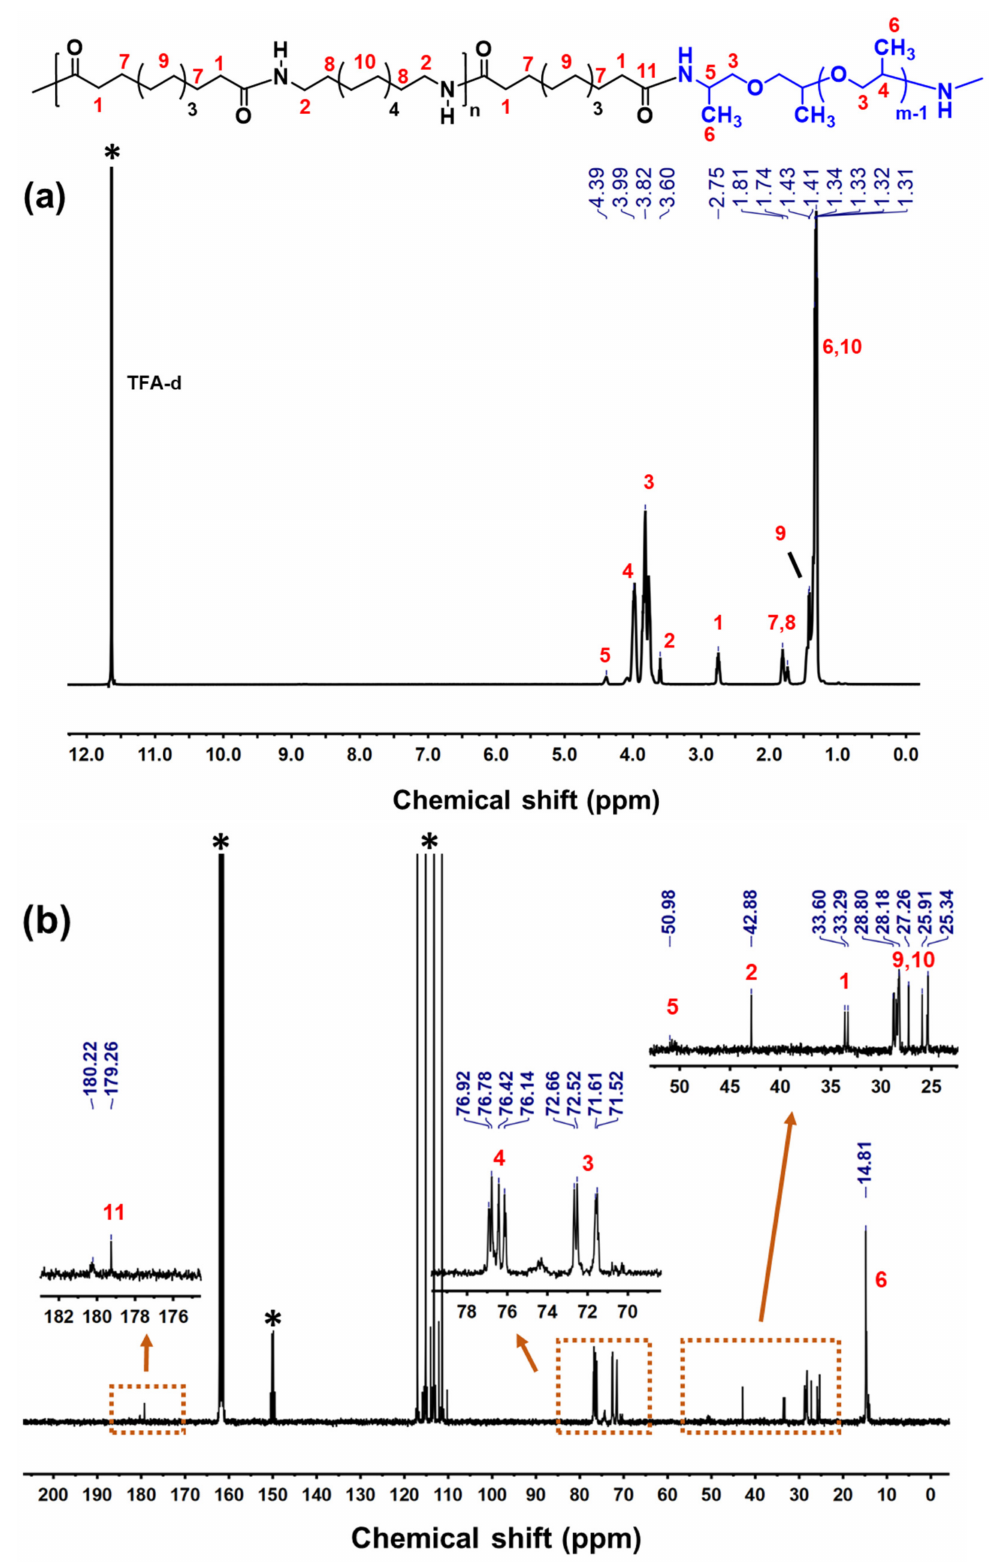
Figure 1. 1 H NMR ( a ) and 13 C NMR ( b ) spectrum of TPAE-0.76 (* Solvent: